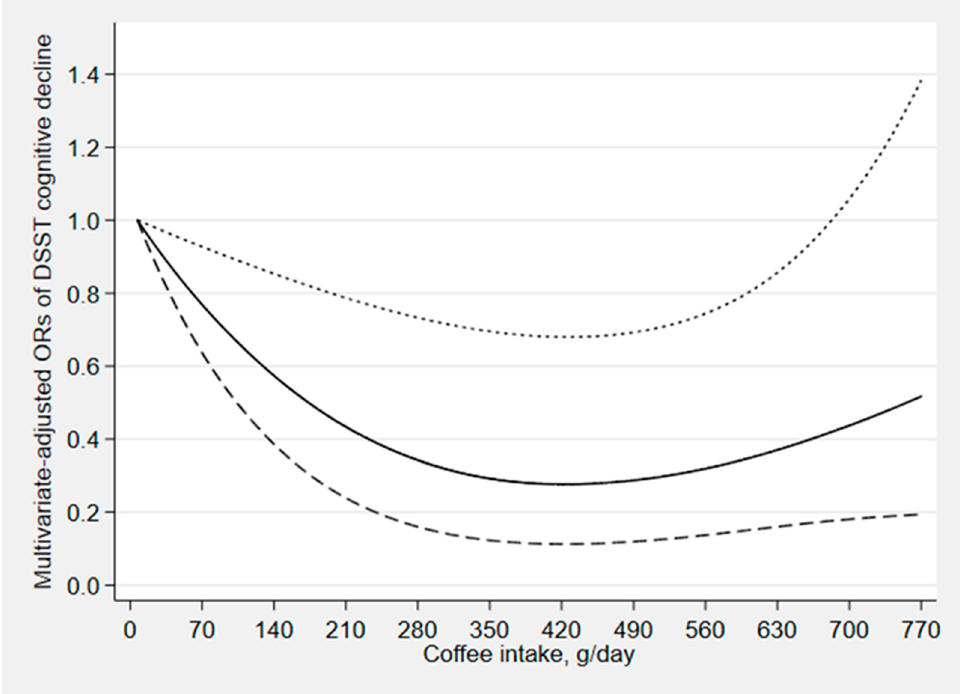
Figure 2. Dose–response relationship between coffee intake and DSST score. The solid line and dashed line represent the estimated ORs and their 95% confidence intervals (OR, odds ratio).